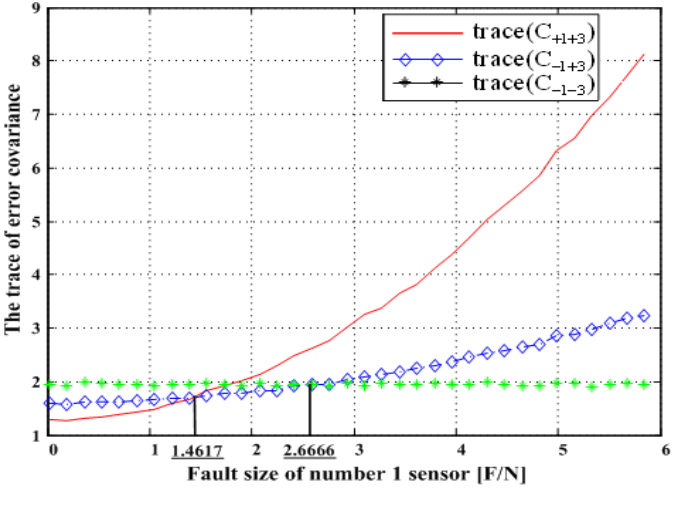
), trace(C )and trace(C ) with respect to fault magnitude in Figure +1+3 -1+3 -1-3